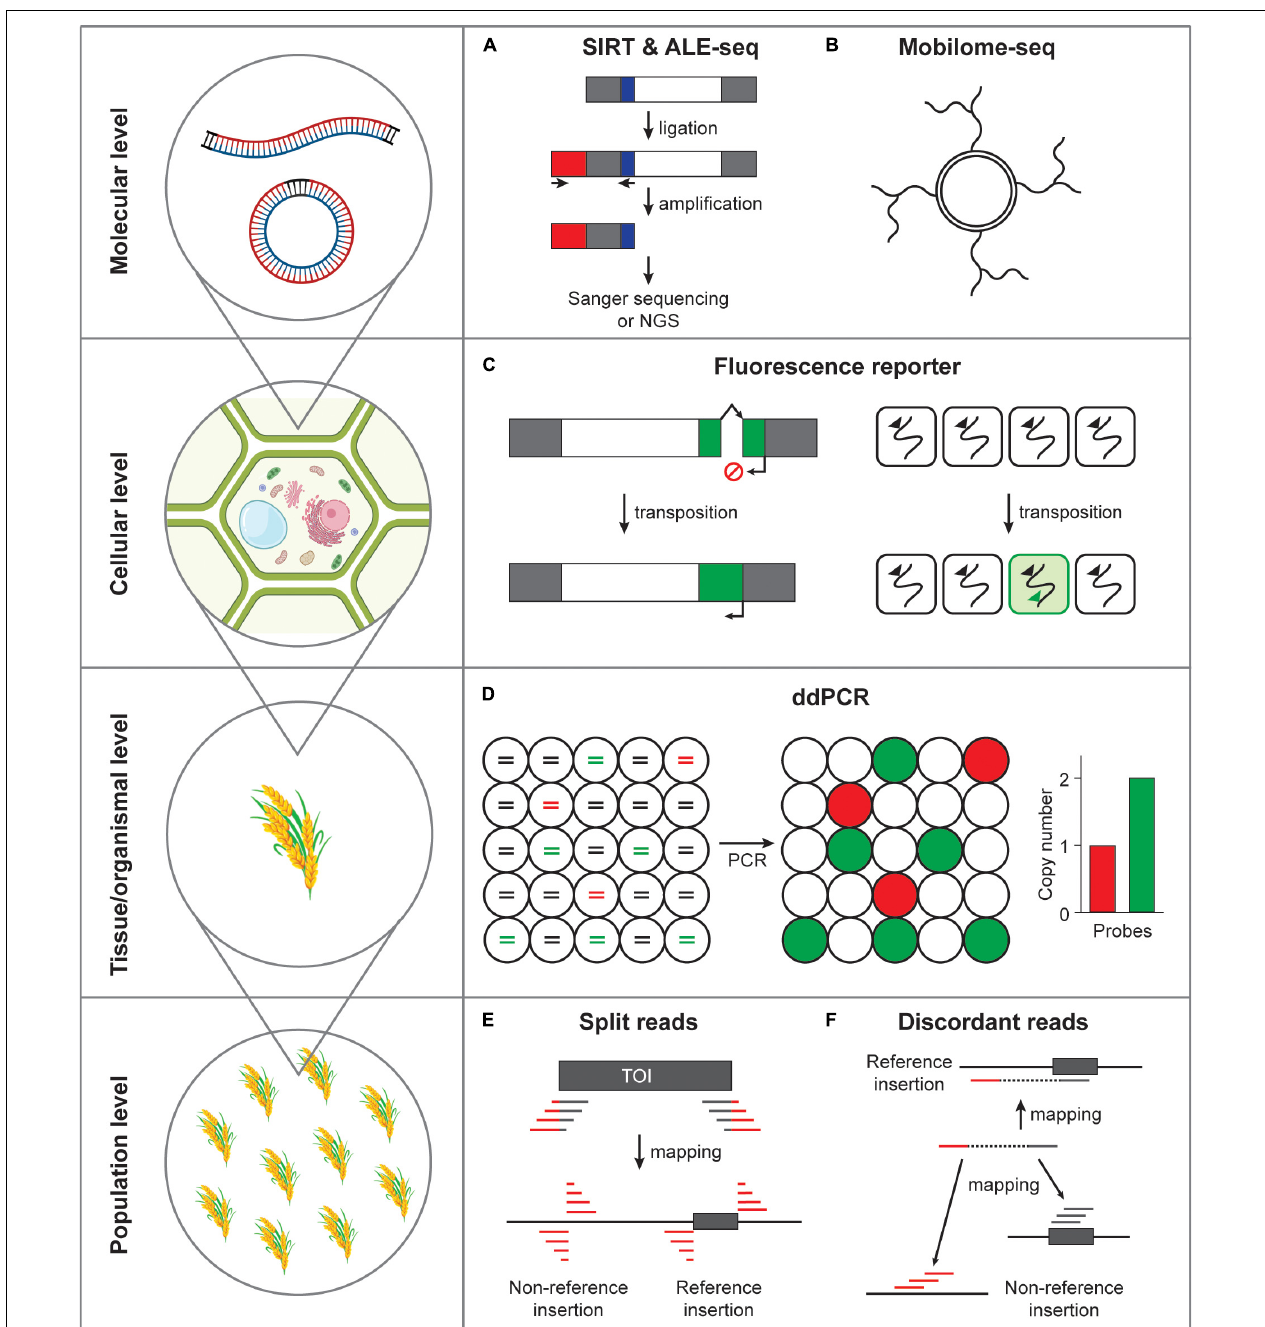
FIGURE 2 | Methods detecting transposon mobility at varying scales. (A) Activated retrotransposon gives rise to extrachromosomal DNAs in both linear and circular forms. SIRT and ALE-seq are the methods that can detect linear DNA intermediates of retroelements. Gray box, long terminal repeats; white box, open reading frame; red box, adapter; blue box, PBS. (B) Extrachromosomal circular DNAs can be amplified by the isothermal strand displacement DNA polymerization. (C) Fluorescence reporter retrotransposition system can specifically label the cells in which transposition occurred. Green box, fluorescence reporter gene; arrows, transcriptional start sites; broken arrow, intron. (D) Transposon mobilization at tissue or organismal level can be assessed by ddPCR. Fragmented DNAs are randomly distributed in separate droplets and independently amplified. Lines in circles represent fragmented genomic DNA colored for different PCR templates. Red, a single-copy reference gene; green, transposon of interest; black, non-templated DNA. (E) The split reads method uses the reads tagged with transposon sequences that map to the insertion positions. TOI, transposon of interest; gray box, transposon; gray line, transposon sequence; red line, flanking sequence of transposon. (F) The discordant reads method uses the paired-end reads, which map to transposon from one side and to a distant genomic site from the other side of a read pair.